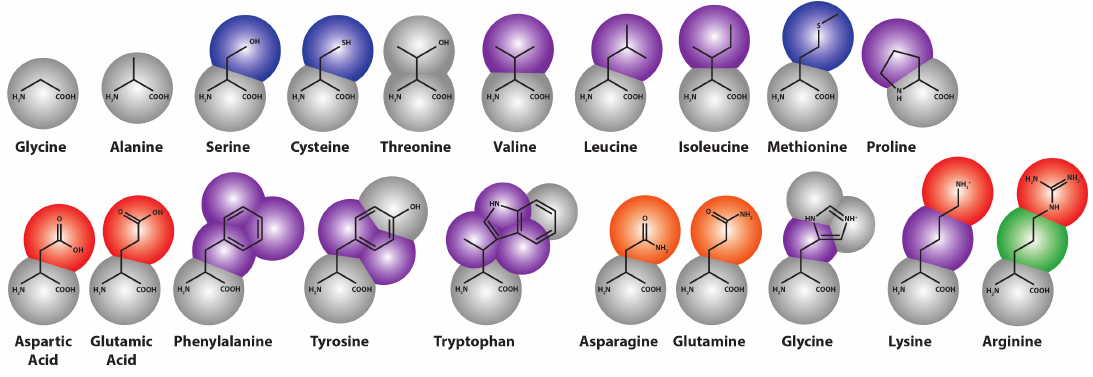
Figure 3. Coarse-grained representation of the Martini model extension to amino acids [181], colored by bead type (where purple is apolar, blue and green are intermediate, gray and orange are polar and red represents charged